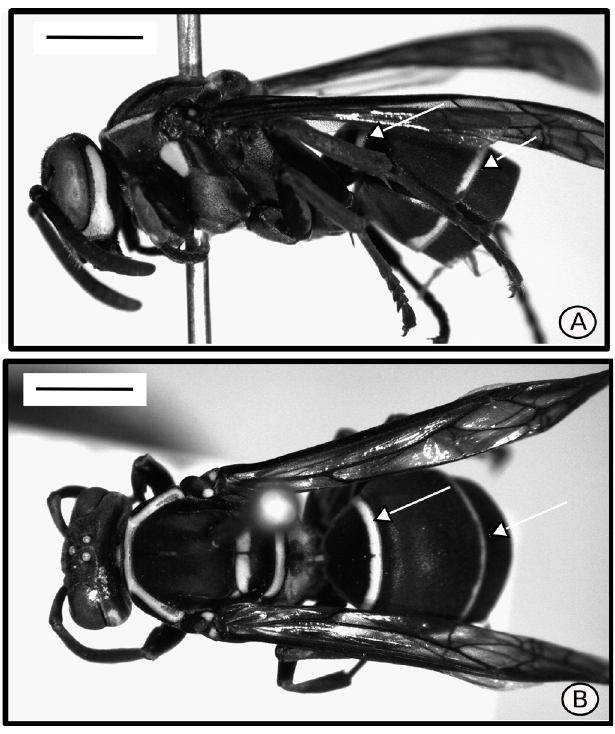
Fig 1 . Worker of Chartergellus trinitatis (A) lateral view; (B) dorsal view. Arrows pointing to yellow bands on metasoma. Scale bar = 2.0 mm.